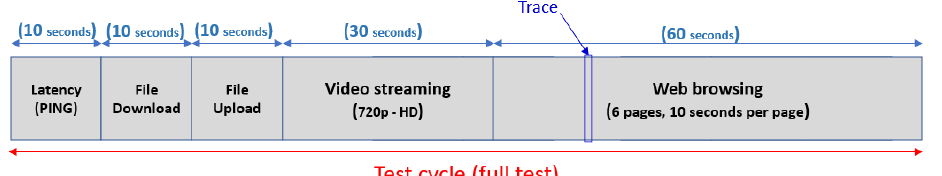
Figure 2. Test cycle overview.